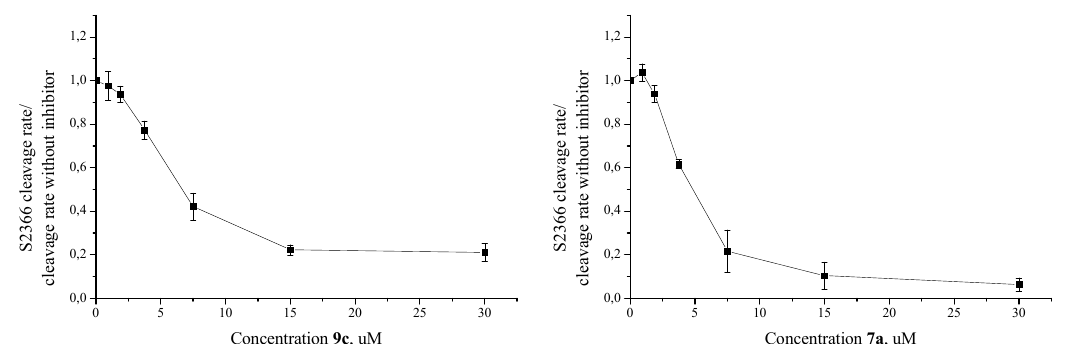
Figure 5. The dependence of inhibition of factor XIa-induced chromogenic substrate hydrolysis on the inhibitor concentration. Table 2. Results of the experimental measurements of the IC 50 values of factor XIa inhibition for various compounds.